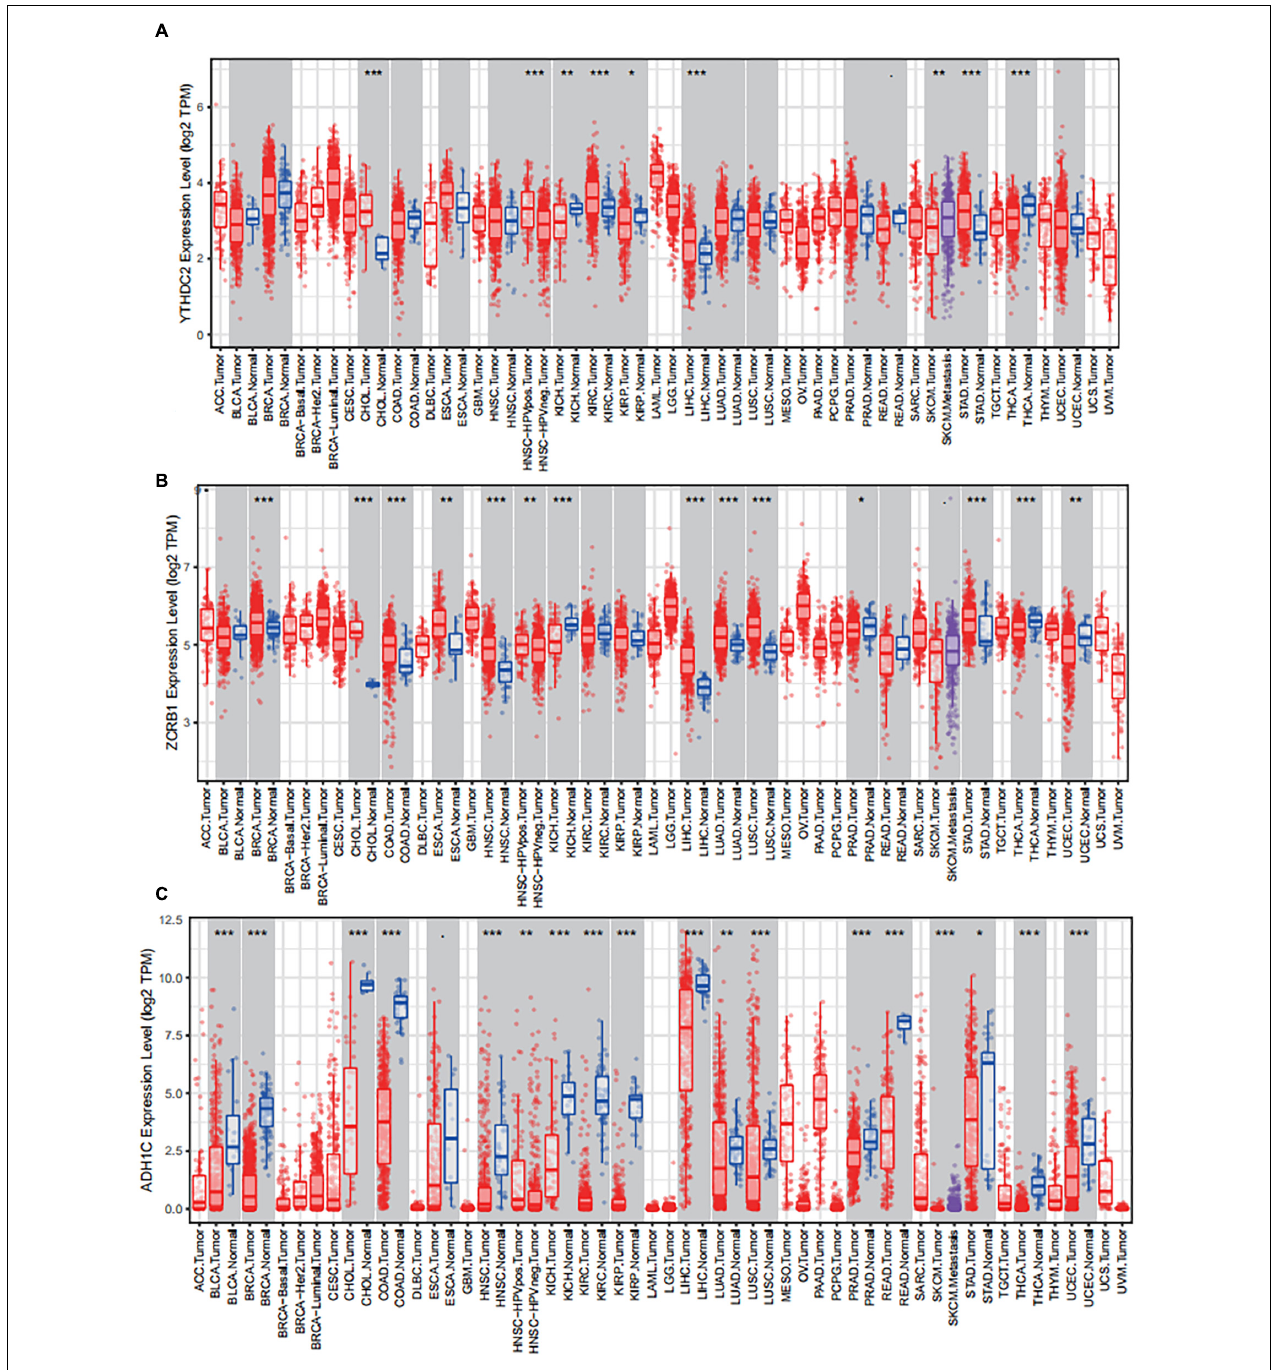
FIGURE 6 | The expression of the three predictive genes in cancers via Tumor IMmune Estimation Resource (TIMER, https://cistrome.shinyapps.io/timer/). (A) YTHDC2 expression level in tumor tissues vs normal tissues. (B) ZCRB1 expression level in tumor tissues vs normal tissues. (C) ADH1C expression level in tumor tissues vs normal tissues. ACC, adrenocortical carcinoma; BLCA, bladder carcinoma; BRCA, breast carcinoma; CESC, cervical squamous cell carcinoma and endocervical adenocarcinoma; CHOL, cholangio carcinoma; COAD, colon adenocarcinoma; DLBC, lymphoid neoplasm diffuse large B-cell lymphoma; ESCA, esophageal carcinoma; GBM, glioblastoma multiforme; HNSC, head and neck squamous cell carcinoma; KICH, kidney chromophobe; KIRC, kidney renal clear cell carcinoma; KIRP, kidney renal papillary cell carcinoma; LAML, acute myeloid leukemia; LGG, brain lower grade glioma; LIHC, liver hepatocellular carcinoma; LUAD, lung adenocarcinoma; LUAC, lung squamous cell carcinoma; MESO, mesothelioma; OV, ovarian serous cystadenocarcinoma; PAAD, pancreatic adenocarcinoma; PCPG, pheochromocytoma and paraganglioma; PRAD, prostate adenocarcinoma; READ, rectum adenocarcinoma; SARC, sarcoma; SKCM, skin cutaneous melanoma; STAD, stomach adenocarcinoma; TGCT, testicular germ cell tumors; THCA, thyroid carcinoma; THYM, thymoma; UCEC, uterine corpus endometrial carcinoma; UCS, uterine carcinosarcoma; UVM, uveal melanoma.